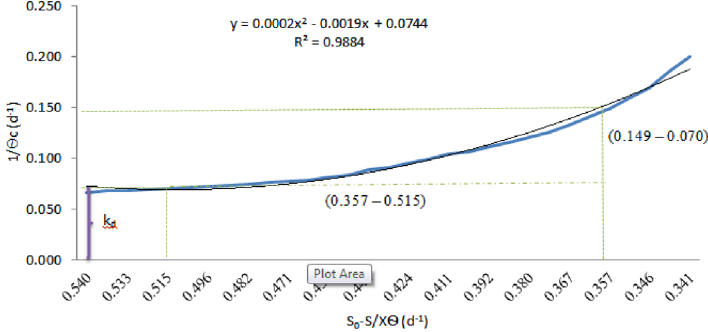
Figure 5. Estimated the k d , Y and, µmax in ASM 2.